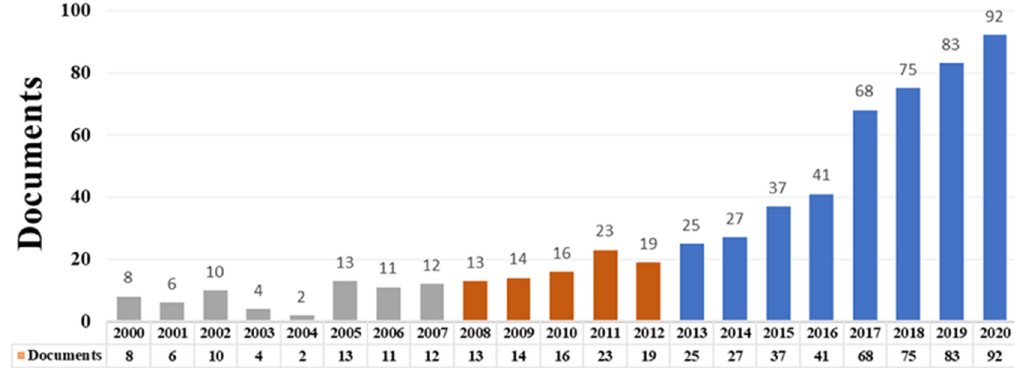
Figure 2. Number of land consolidation research documents published from 2000 to 2020.